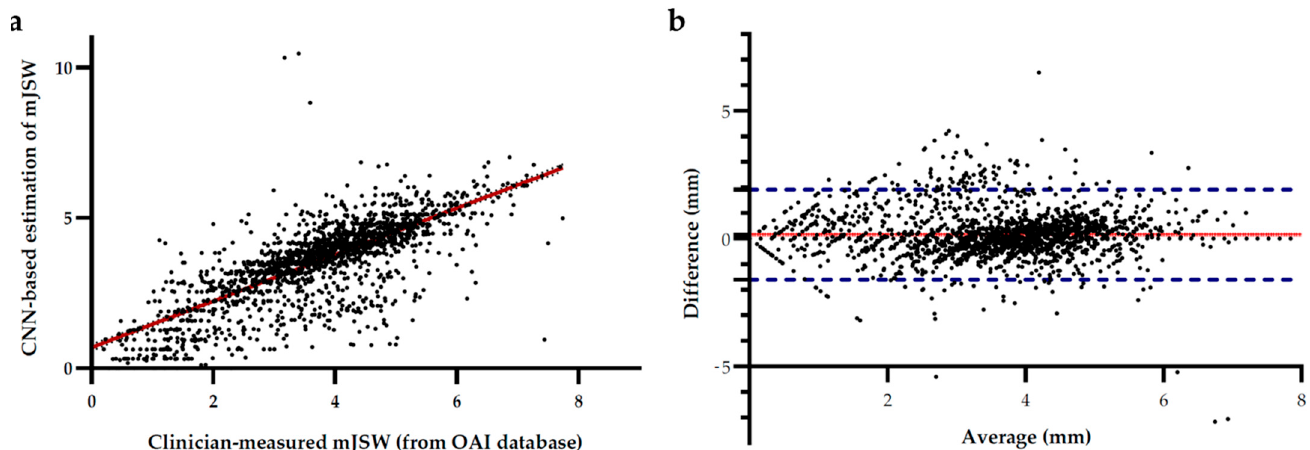
Figure 4. ( a ) Linear regression between minimum-JSW measurements by radiologists or orthopedic doctors (from OAI database) and the proposed deep learning-based automated minimum-JSW estimation approach. The regression line is colored in red with an R 2 value of 0.6086 and a Pearson correlation of 0.7801 ( p < 0.0001). ( b ) Bland-Altman plot for comparison between minimum-JSW measurements by radiologists (from OAI database) and our CNN-based automated approach. The Blue dotted line indicates the 95% confidence interval of the difference between the two types of measurement. The red solid line indicates the mean bias of the measurement.